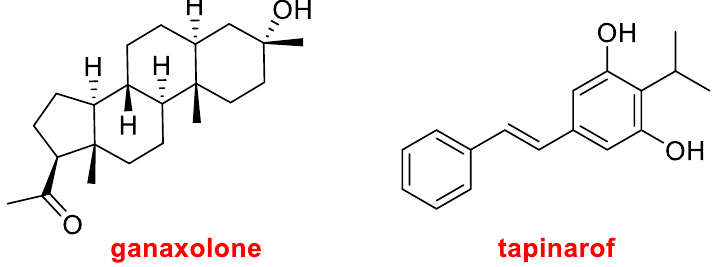
Figure 10. Structures of ganaxolone and tapinarof, both drugs inspired by natural products.